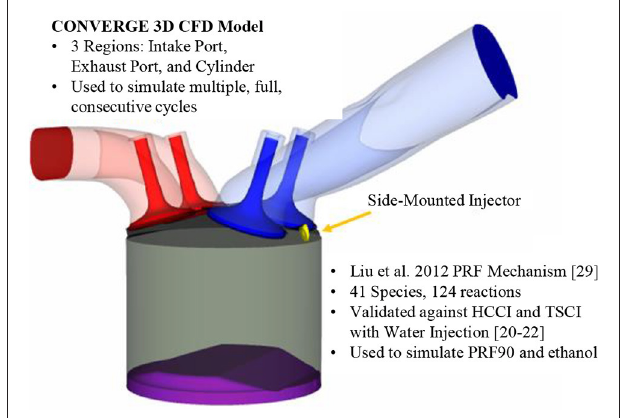
FIGURE 1 | Schematic of the CFD model.